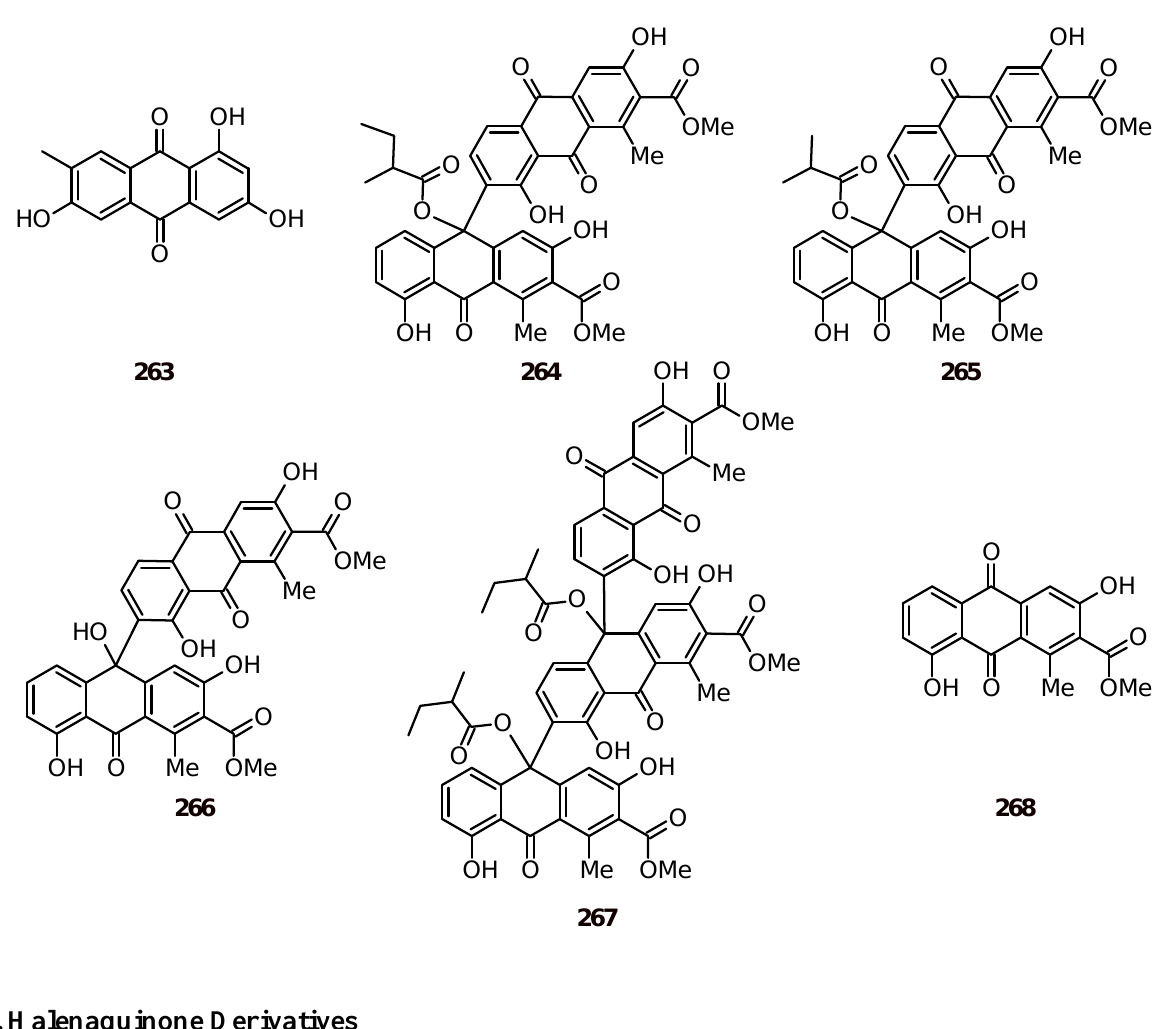
Figure 32. Structures of anthraquinones and anthrones 263-268